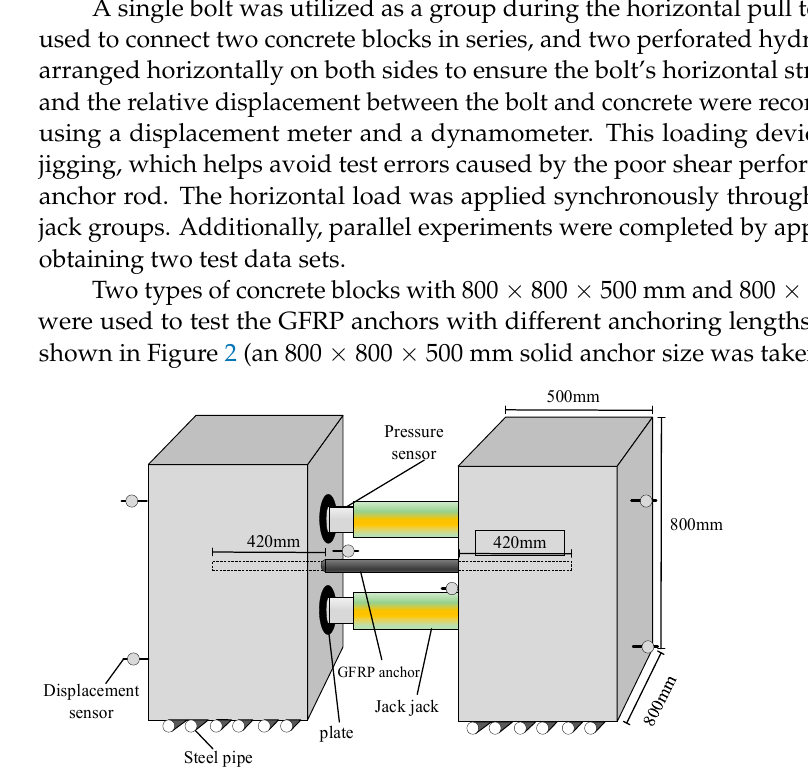
Figure 2. Schematic diagram of the test device.